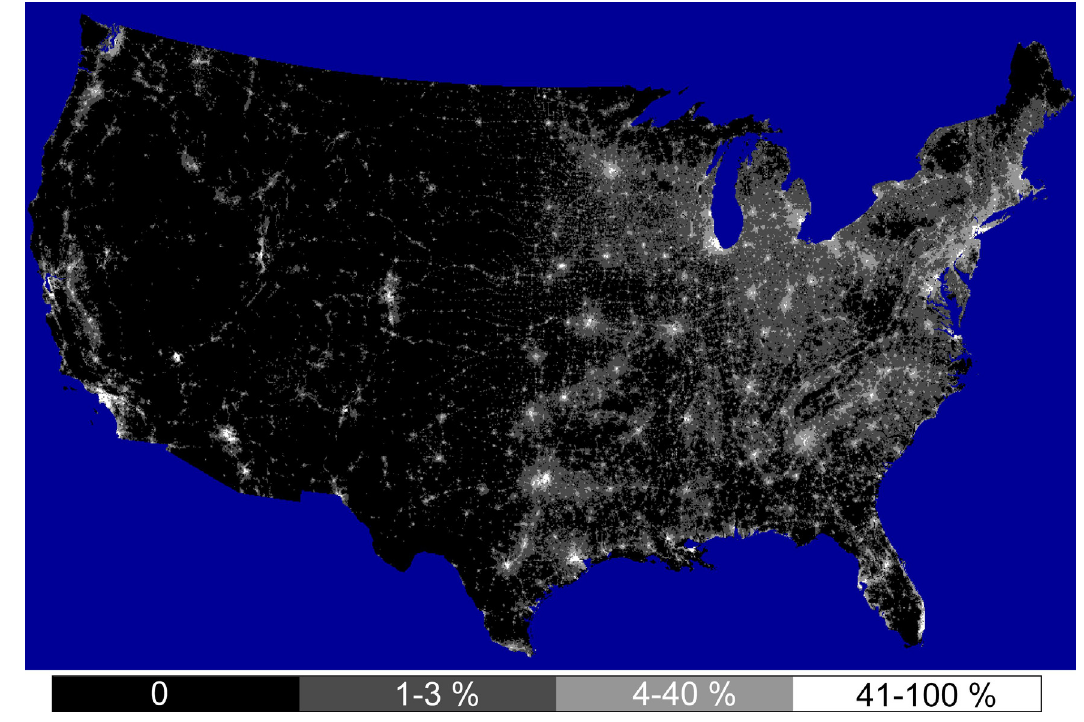
Figure 4. NGDC’s ISA grid of the conterminous USA. The figure shows the density of ISA in four gray scale ranges.